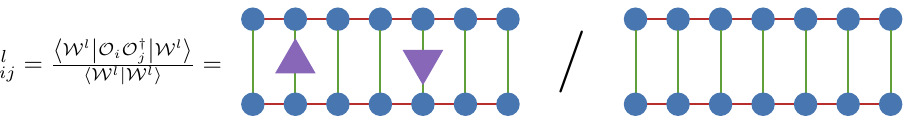
Figure 4 . Two site correlation of the MPS, shown with blue nodes and |Wi , with respect to an operator, O also represented via purple triangles. i ( j ) represents the location of the sites to which the operator has been applied, and l is the label